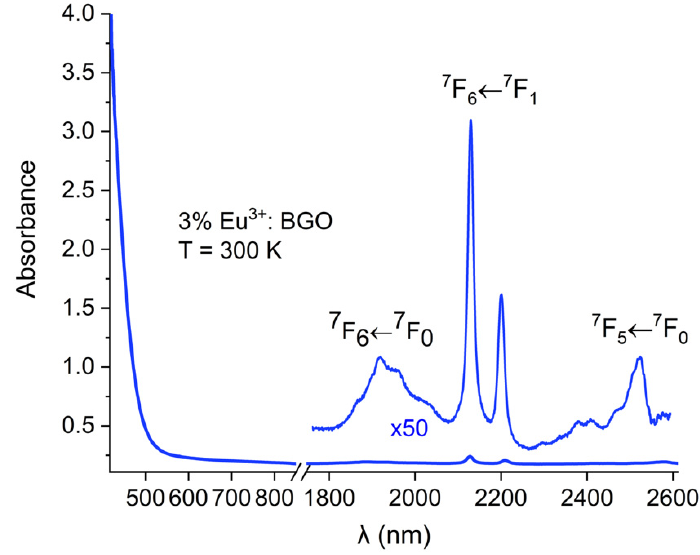
Figure 3. Absorption spectrum of BGO: 3% Eu 3+ at T = 300 K.